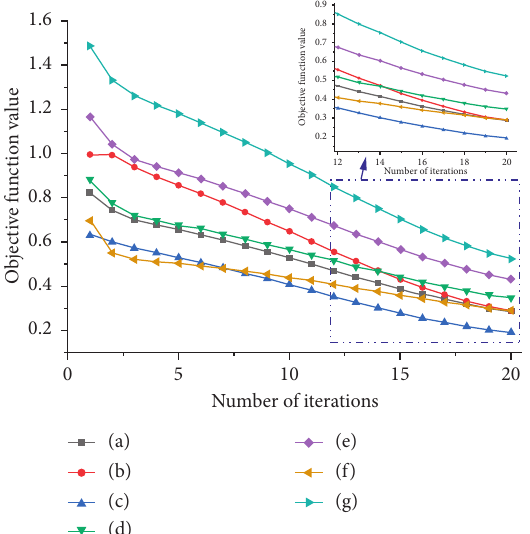
Figure 20: The convergence results of CC-CSI with random weights for “ U -shaped”